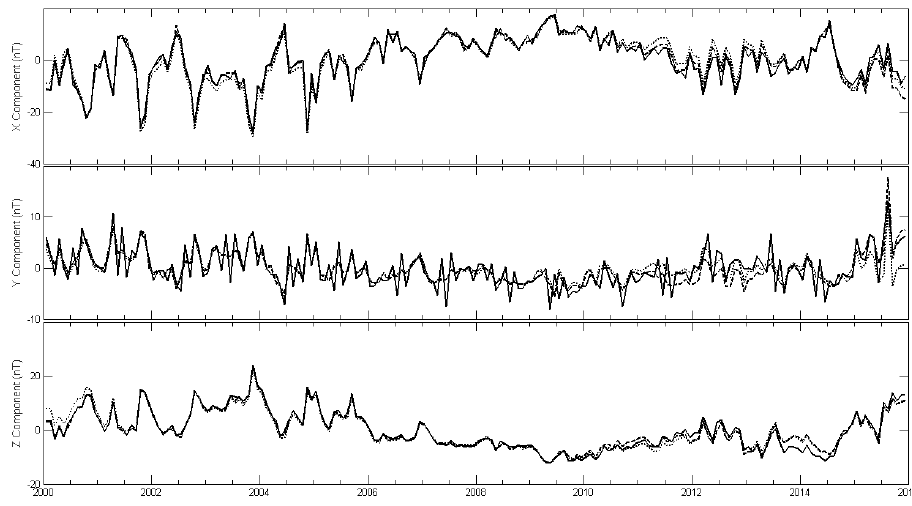
Figure 10. The external contribution to the FUR observatory, calculated as shown in the text for three models: POMME-9 (solid line), EMM2015 (dashed line) and CM5 (dotted